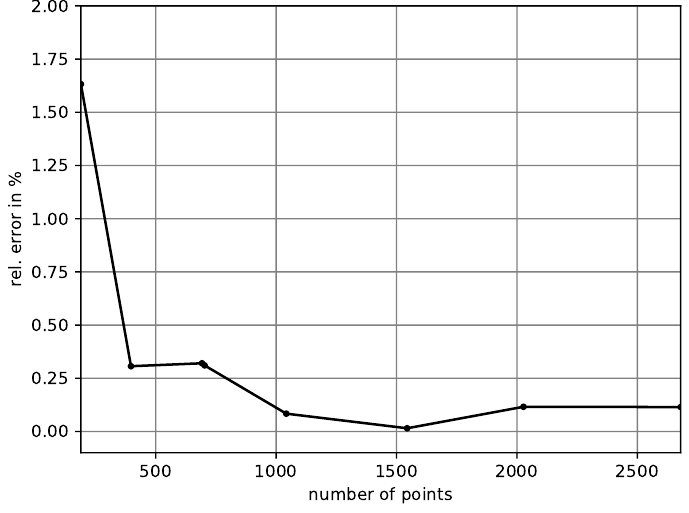
Figure 9. Convergence: Relative error of Z over the number of mesh